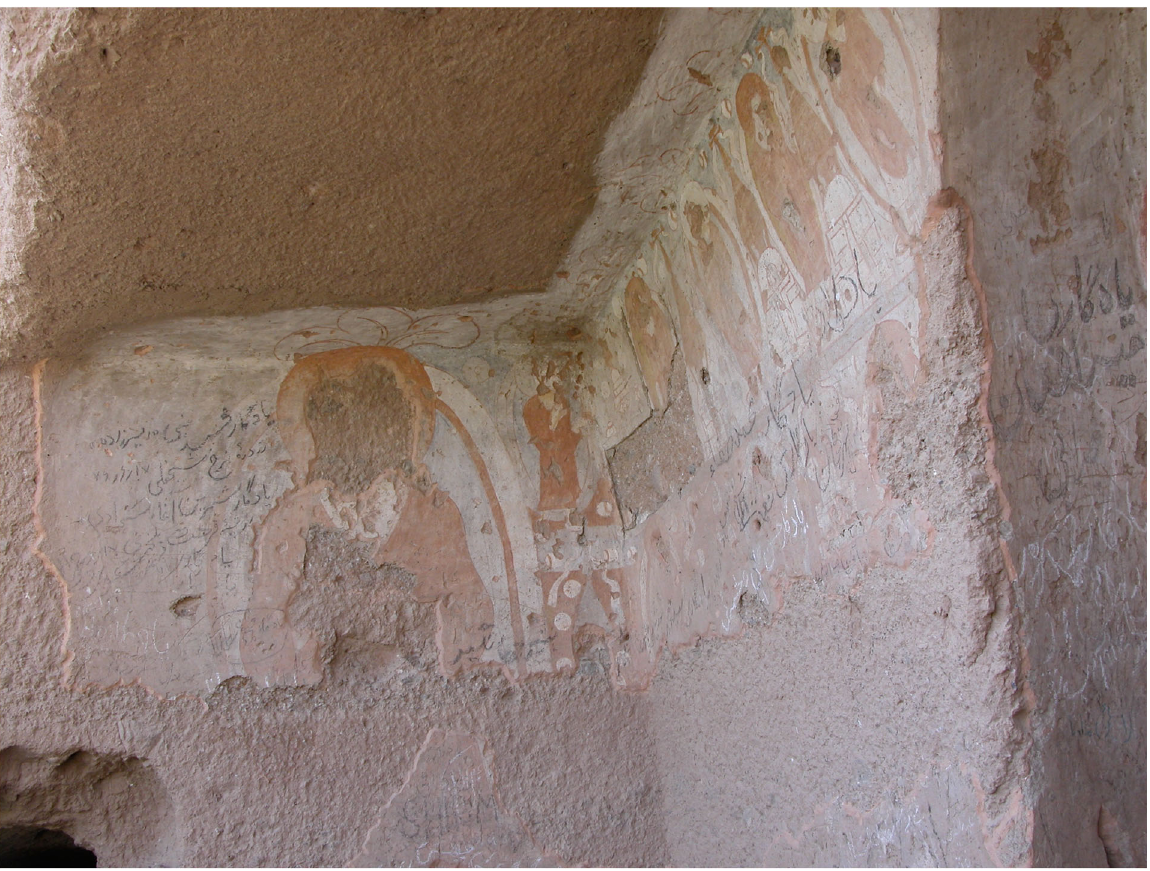
Fig. 4 Decorated surfaces in the Bamiyan Buddha ’ s threated by looting (2003) (Source: the